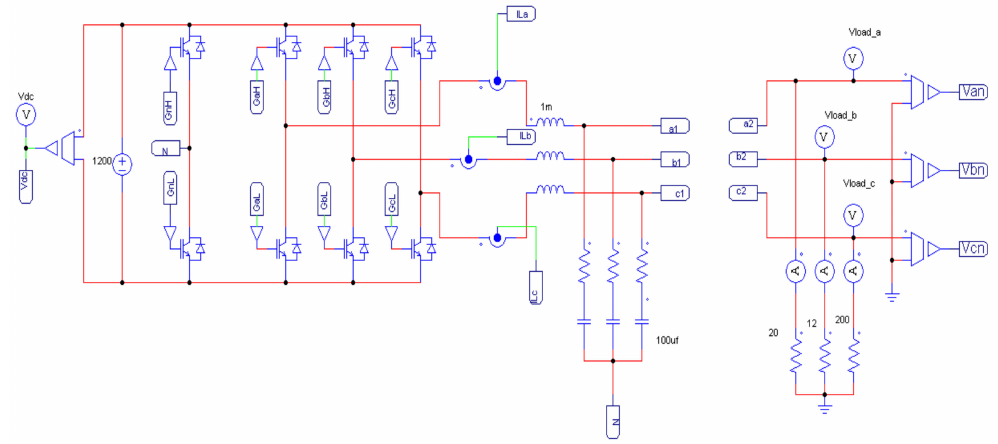
Figure 7. Simulation circuit of microgrid inverter according to transformer type.